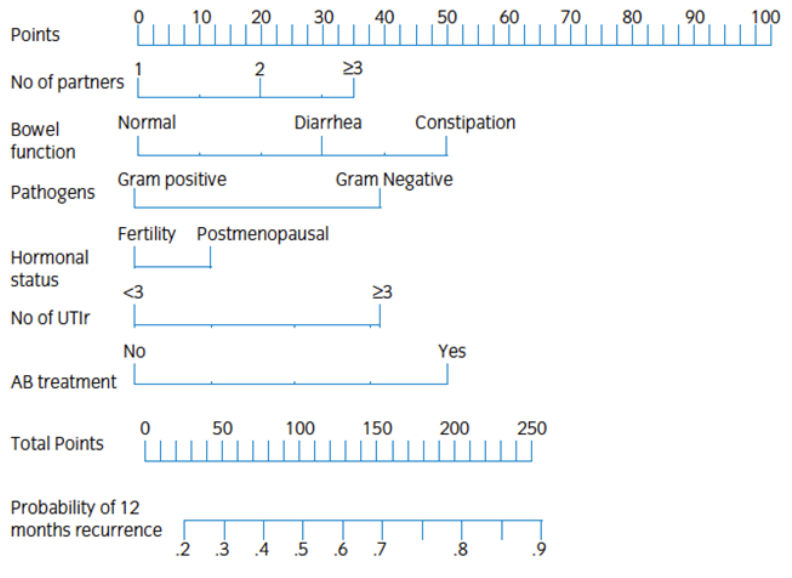
Figure 1: LUTIRE nomogram